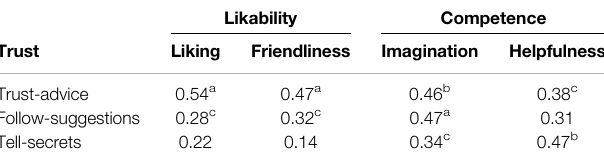
TABLE 4 | Spearman ’ s rank correlations of likability and competence with